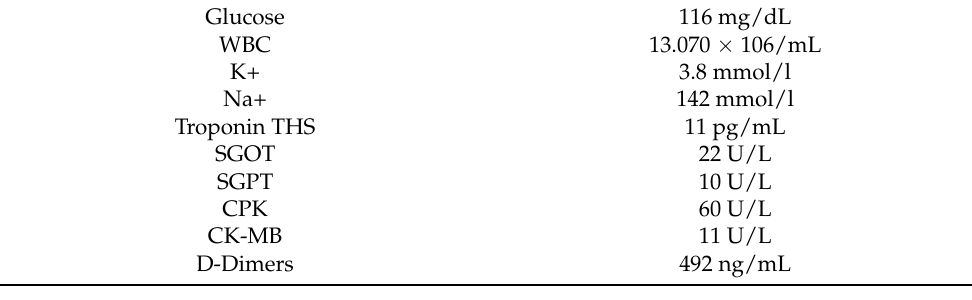
Table 1. Biochemical Tests at admission.